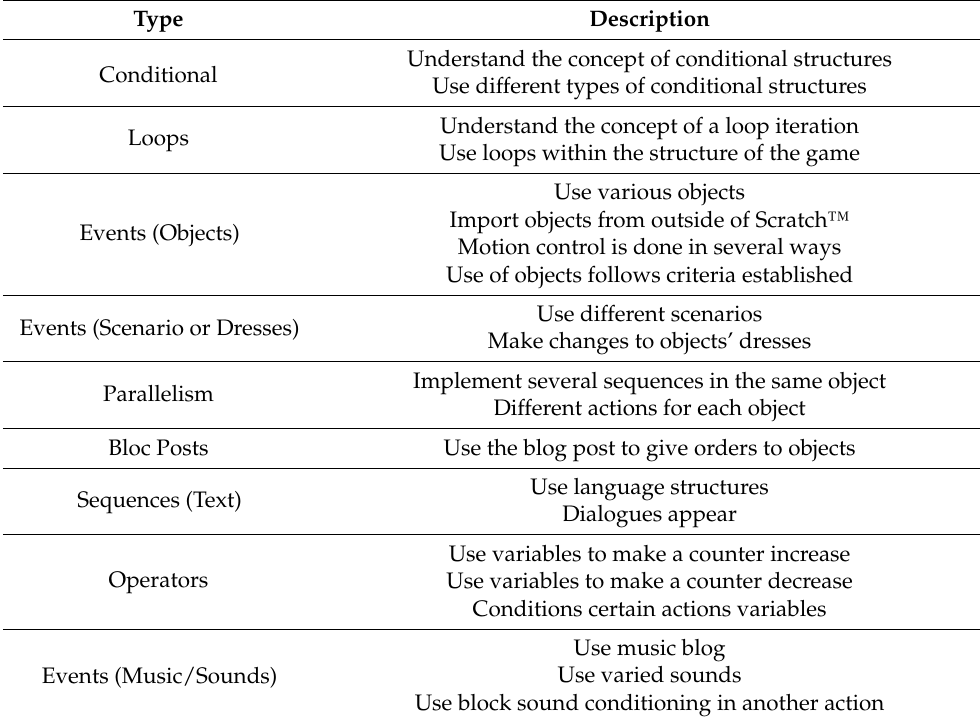
Table 1. Items evaluated on the Scratch™